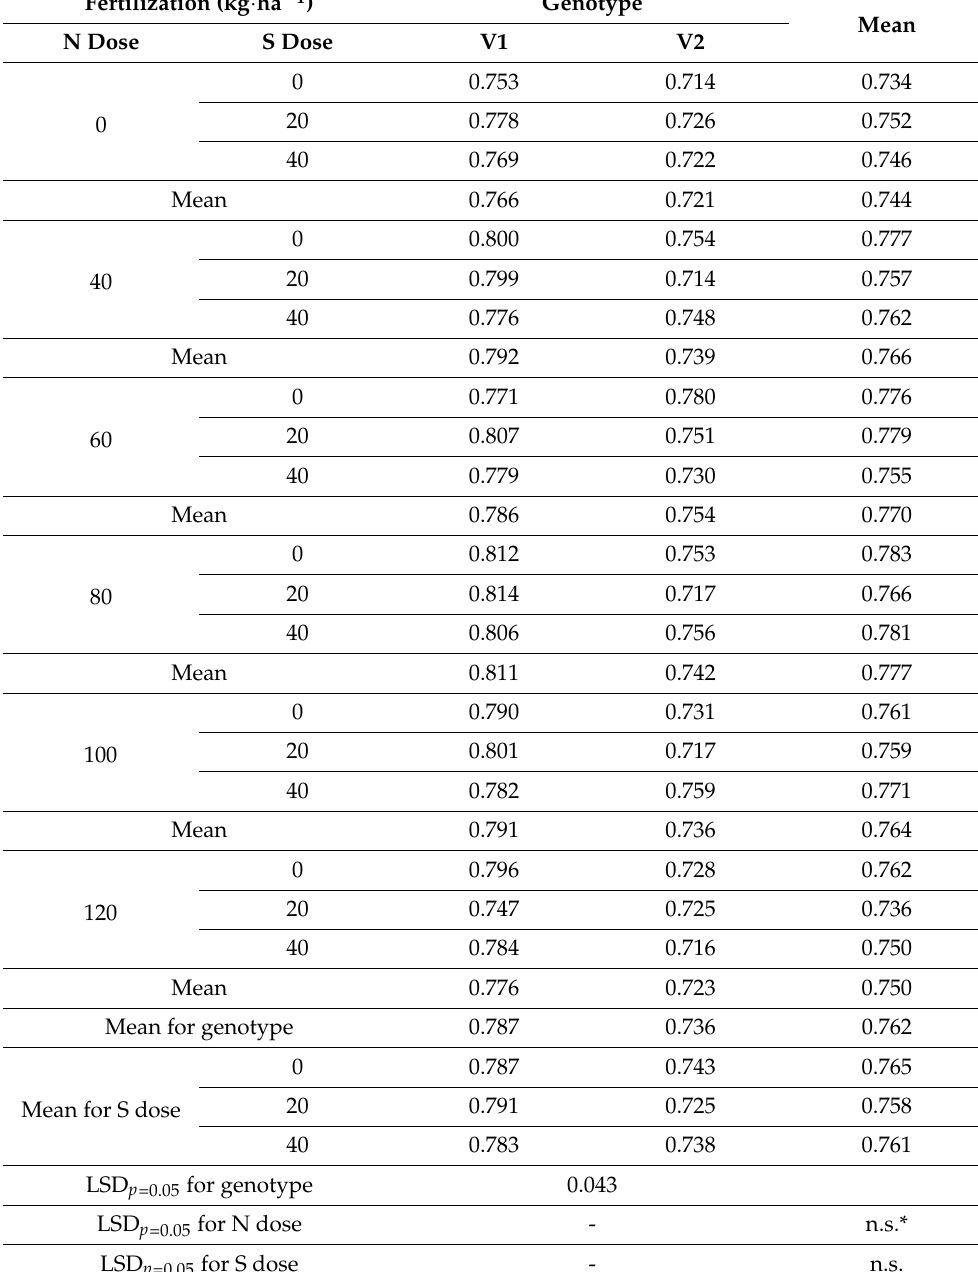
Table 7. GNDVI of winter wheat genotypes under the